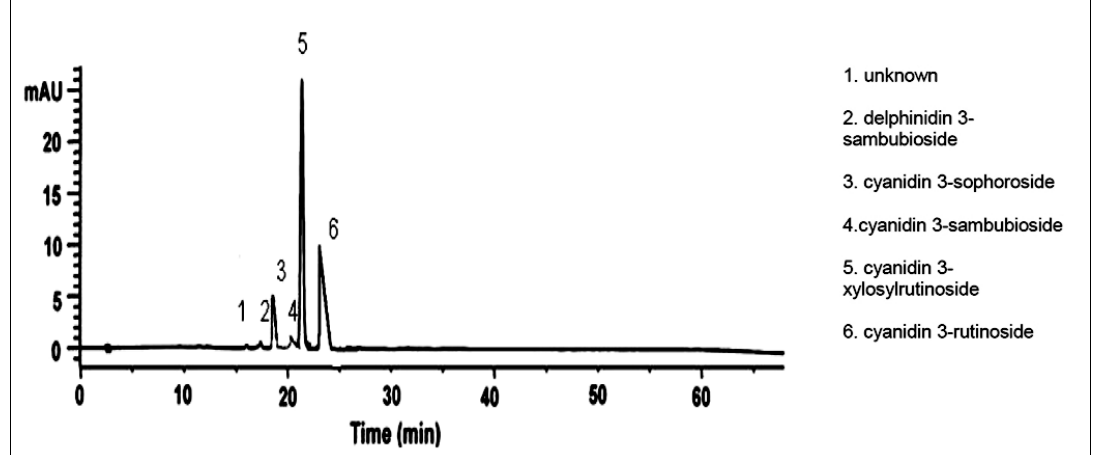
Fig. 3: HPLC separation of anthocyanins detected at 520 nm from red currant (cv Red poll). Peak assignment is provided on the right side.